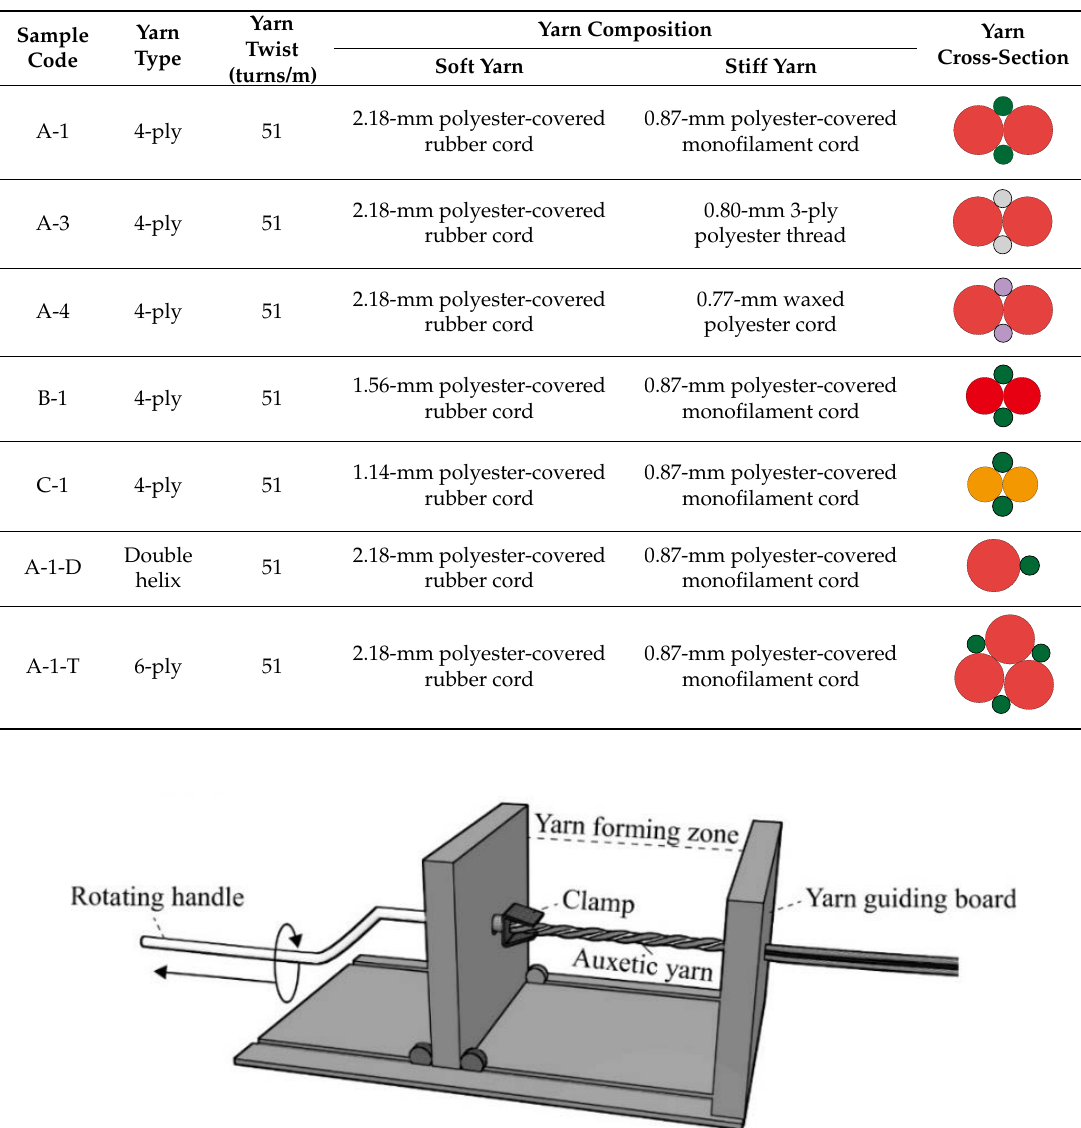
Table 1. Construction characteristics of the auxetic yarn samples.